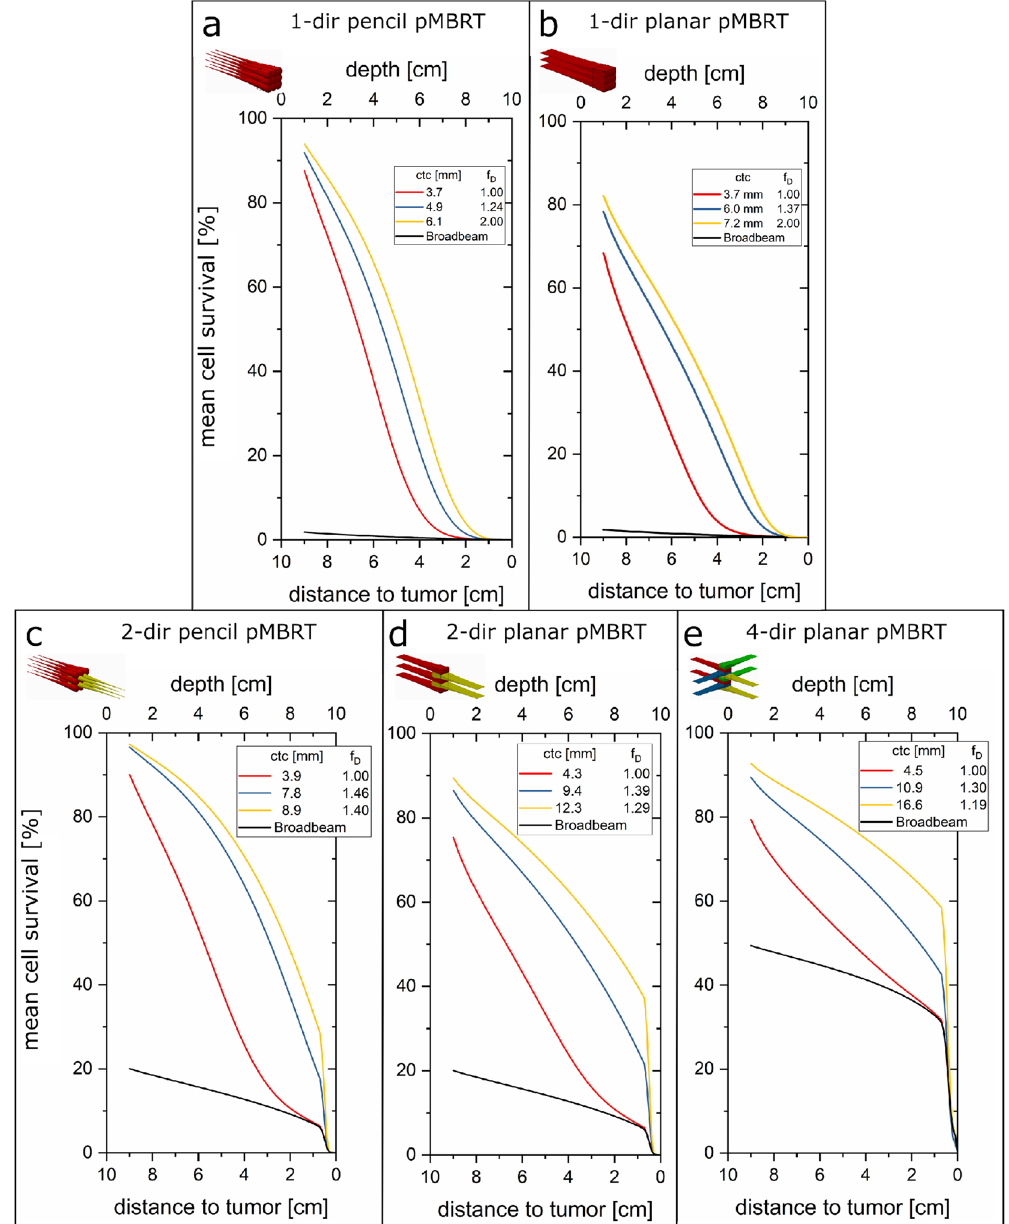
Figure 5. Mean cell survival results for the heterogeneous vs. homogeneous irradiation with planar ( a ) or pencil ( b ) minibeams from one direction, two opposite (2-dir, c and d ) and four directions (4-dir, e ). A minimum dose of 10 Gy within the tumor was